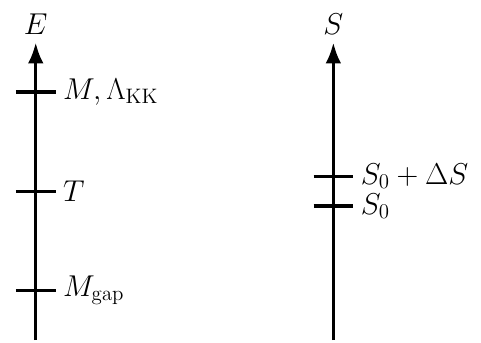
Figure 1 . A schematic diagram of the hierarchy of di(cid:11)erent scales in our setup. This choice in scales ensures that the Jackiw-Teitelboim model is an e(cid:11)ective (cid:12)eld theory that can describe semi-classical, near-extremal black